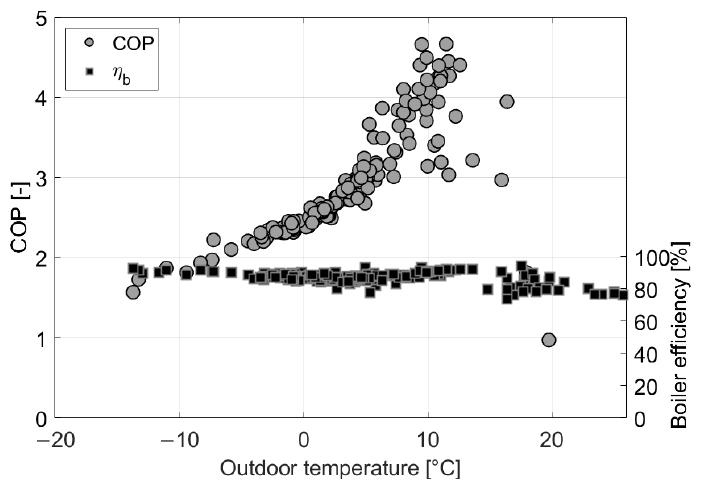
Figure 13. Daily COP and boiler efficiency (axis scaled with the ratio of the CO 2 emission